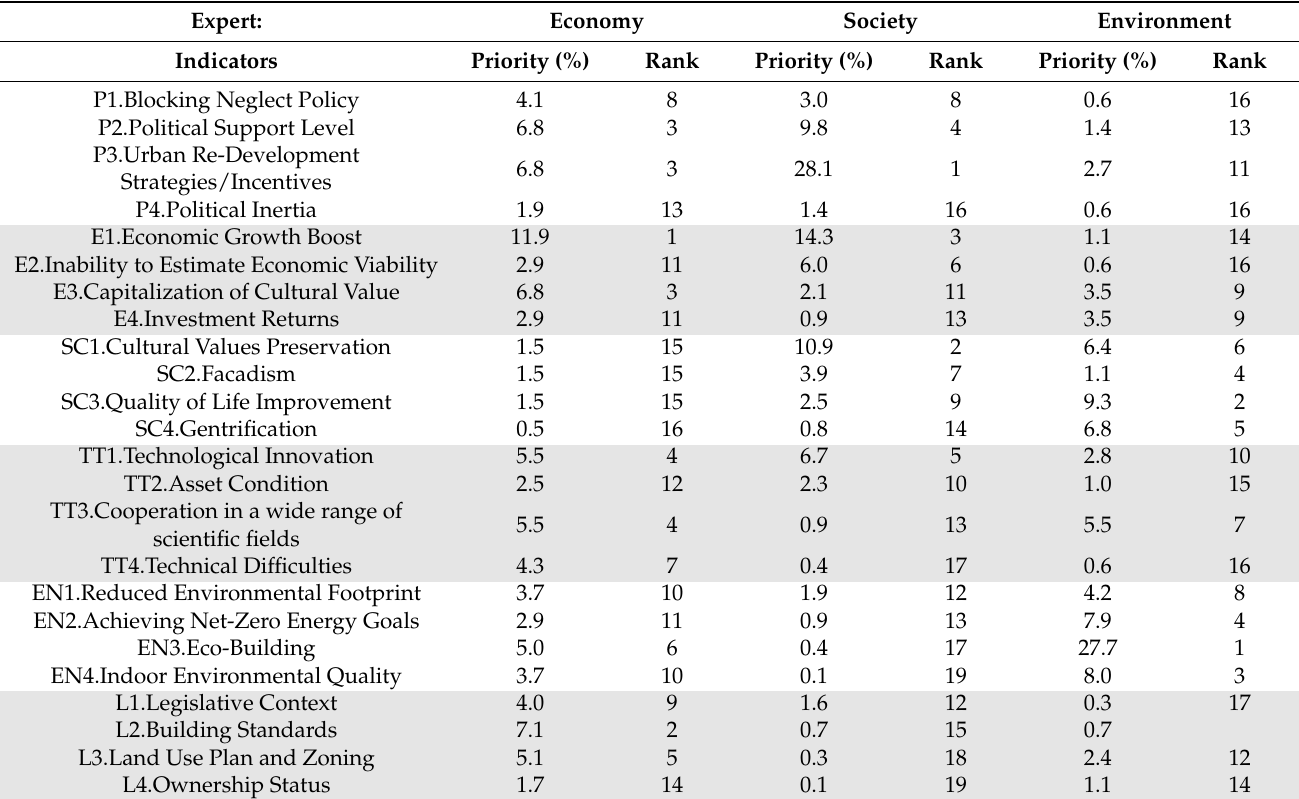
Table 6. Indicators evaluation and rank by expert.